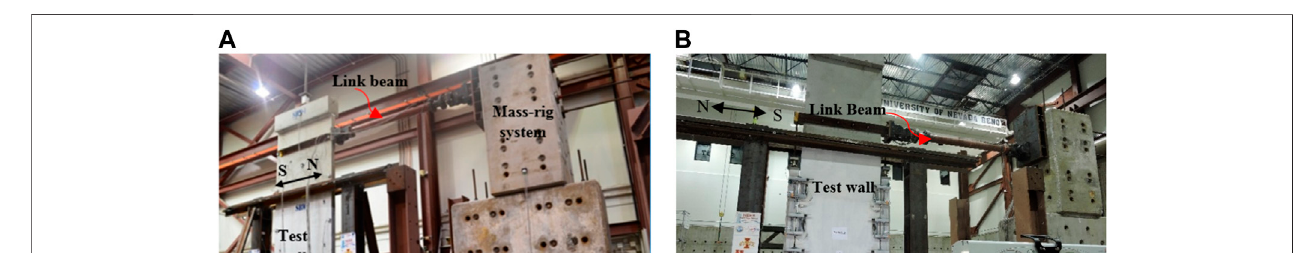
Frontiers in Built Environment |